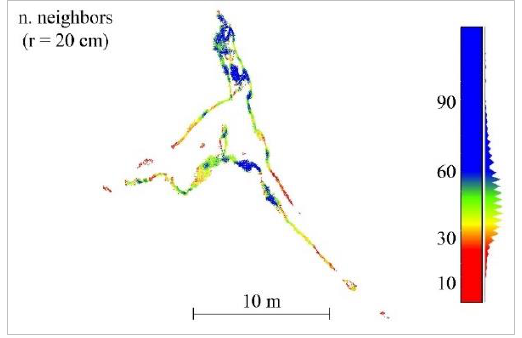
Figure 7. Top: data completeness of the two PC for a section of Trona dell’Acqua. Density of the Ant3D PC is reported in the middle; bottom: Heron Backpack PC density.